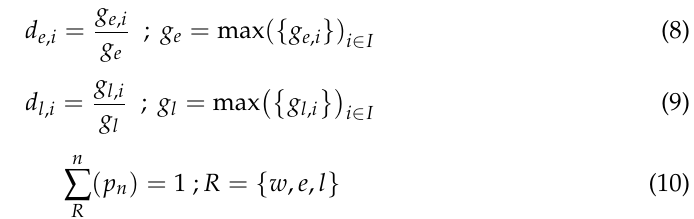
Figure 1b are: point b = 30% E + 20% W + 50% L and point c = 0% E + 60% W + 40% L